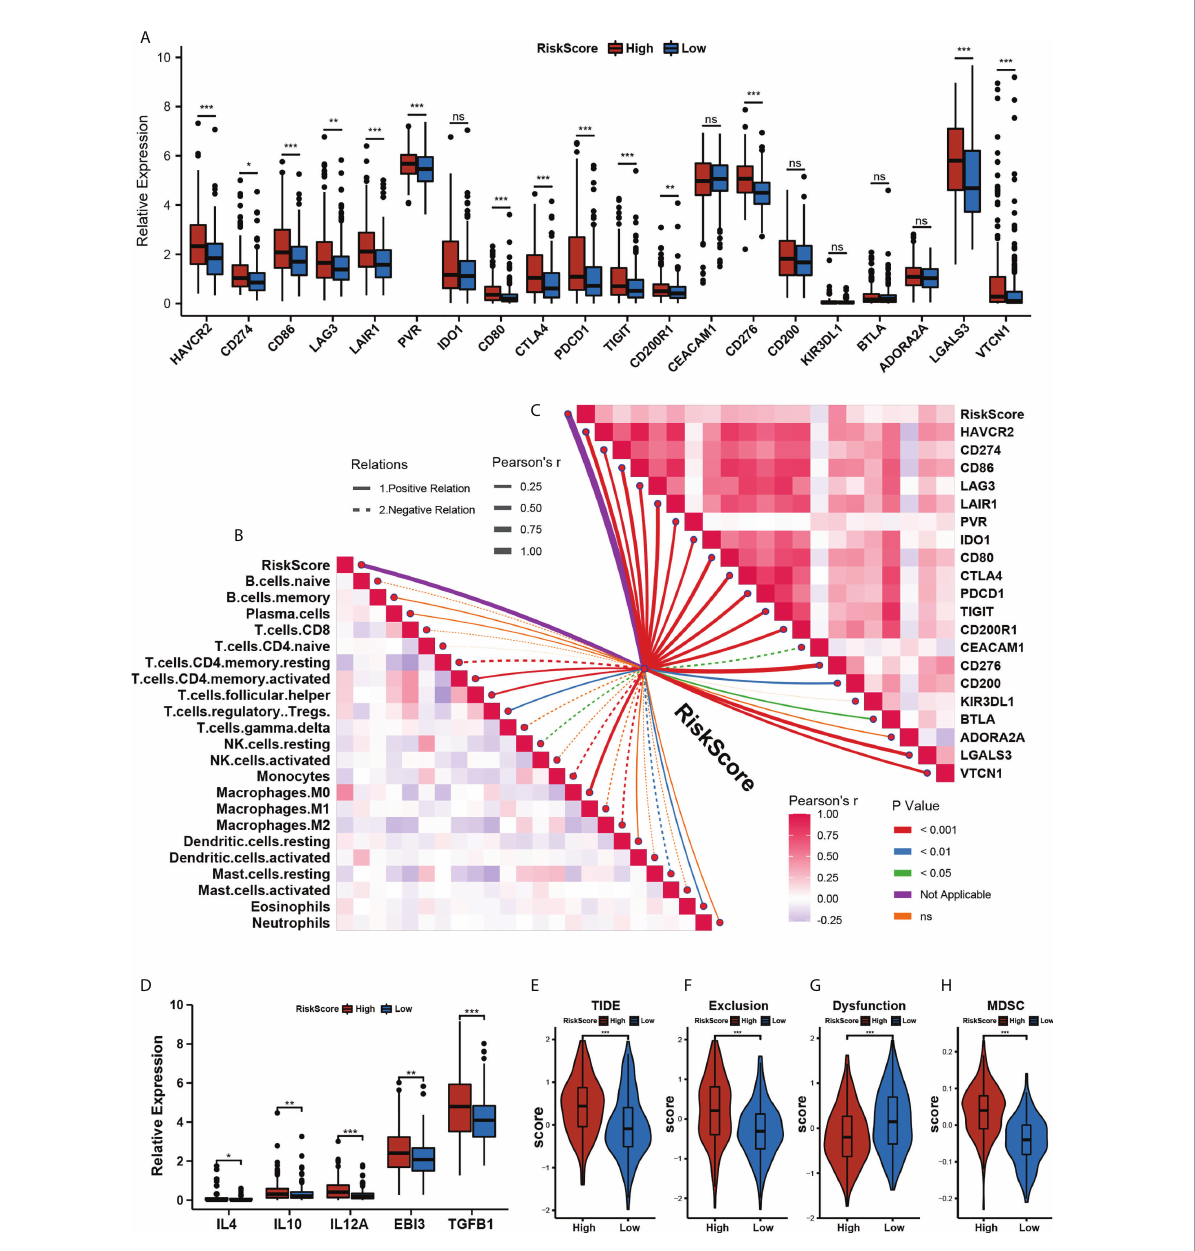
FIGURE 5 Assessing immune microenvironment characterization with the prognostic risk model. (A) The relative expression levels of 20 immune checkpoints in the High- and Low- m 5 C score group.(* p<0.05, ** p<0.01, *** p<0.001, ns: no signi fi cant difference). (B) The correlations between the m 5 C score and immune cell in fi ltration were estimated by using the CIBERSORT algorithm. (C) The correlations between the m 5 C score and immune checkpoints expression. (D) Immunoinhibitory cytokines expression between High- and Low- m5C score groups. (E – H) TIDE (E) Exclusion (F) Dysfunction (G) and MDSC score between High- and Low- m 5 C score groups. (H) Relative distribution of tumor mutation load in High- versus Low- m5C score groups. (* p<0.05, ** p<0.01, *** p<0.001, ns: no signi fi cant